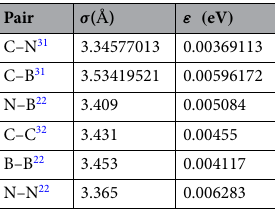
Table 1. Lennard–Jones potential coefficients between different atoms in this study.